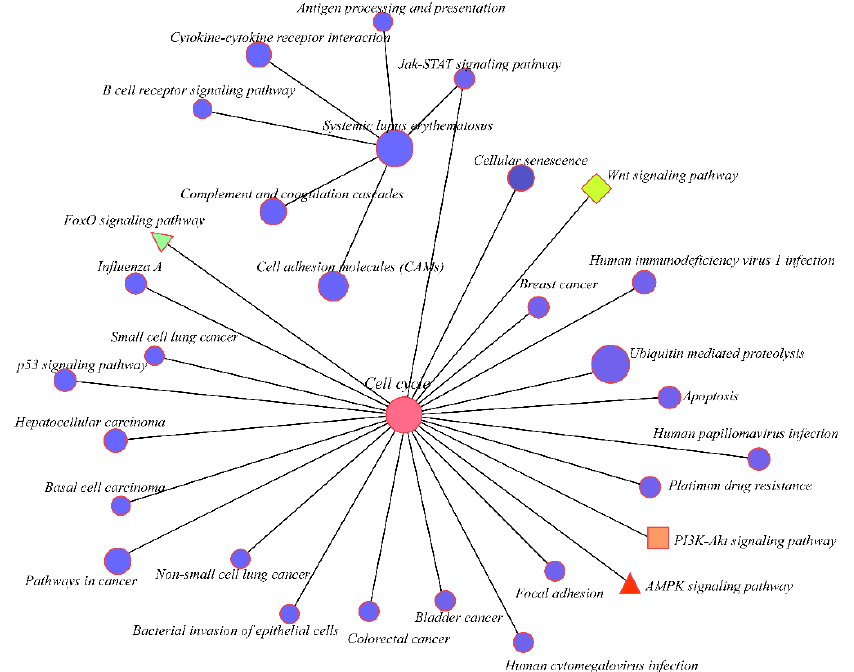
Figure 5. Correlation of the top 20 KEGG pathways. Different colors represent the different enriched pathways.